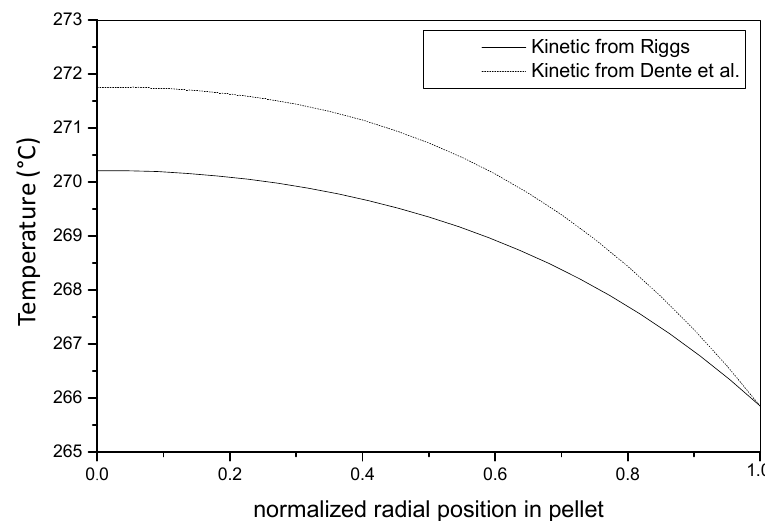
Figure 10. Internal temperature profile for a catalytic particle obtained with different kinetic models.